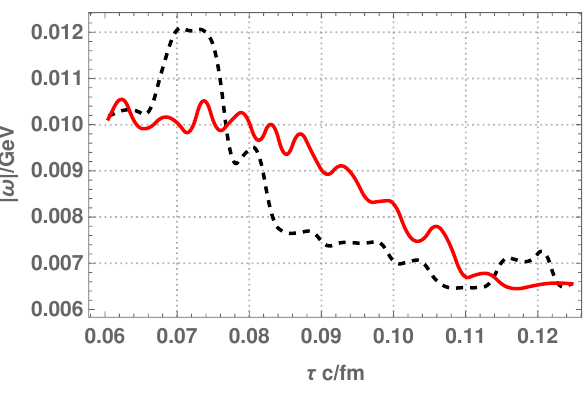
Figure 12 . The median (red solid curve) and the average (black dashed curve) absolute spatial vorticity | ~ω | in the region R defined in (4.5) as a function of proper